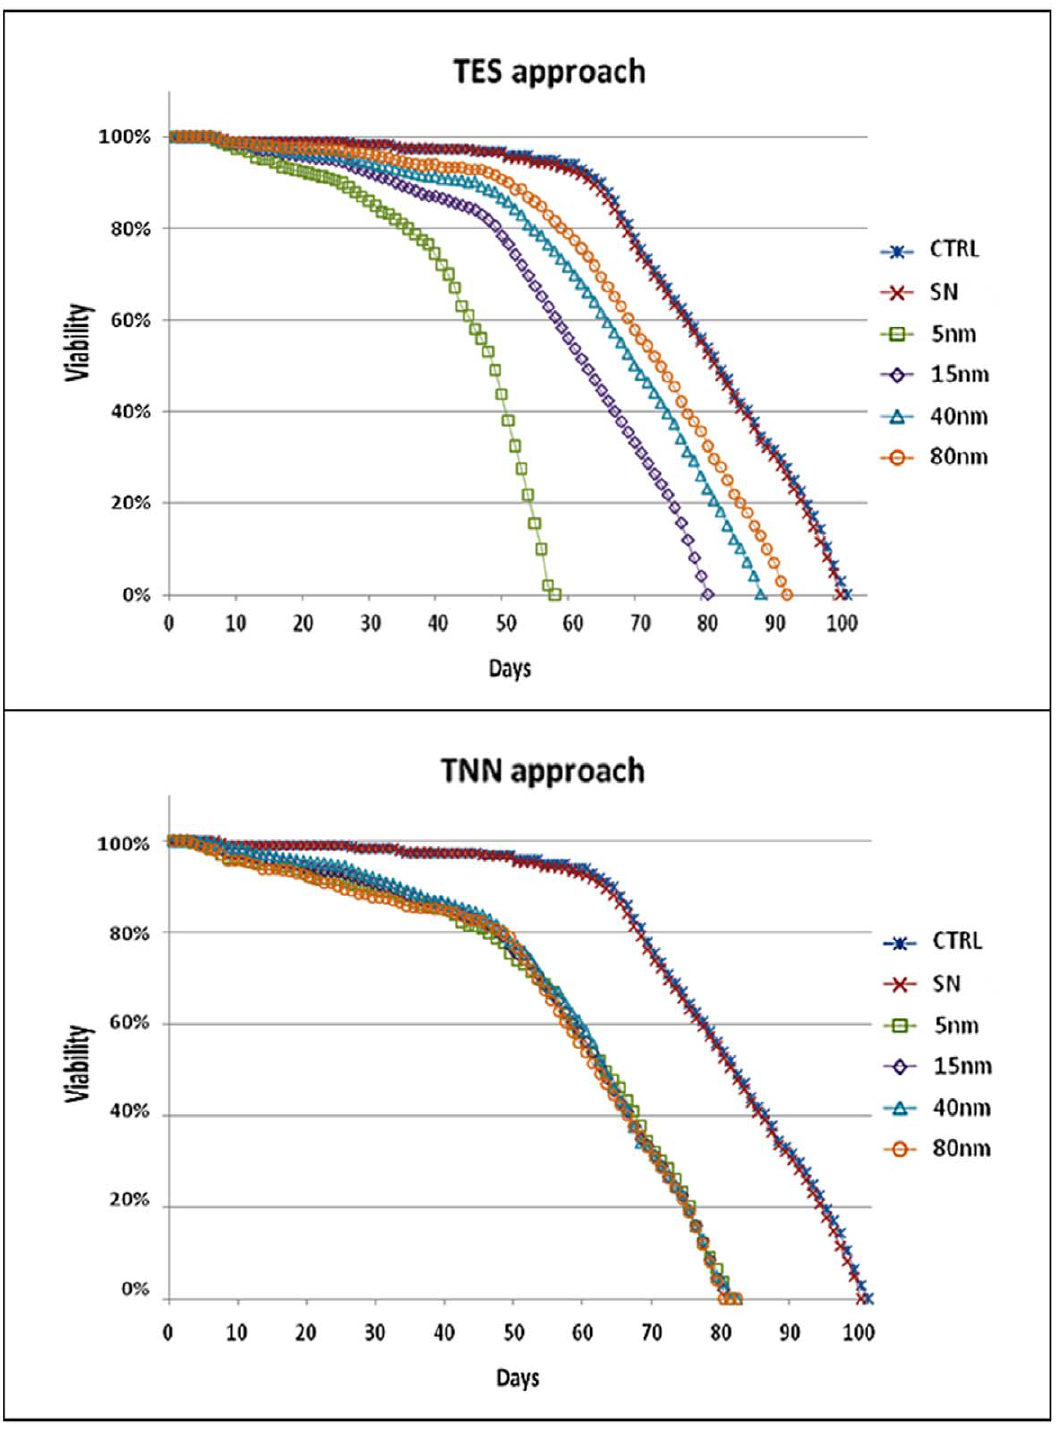
Figure 1. Lifespan curves of Drosophila flies nurtured with AuNPs treated food (5, 15, 40, and 80 nm) compared to two populations bred with normal food (CTRL) or supernatant treated food (SN). Fig. 1, top and bottom, are relative to TES and TNN approach, respectively. Experimental points represent the average from 5 independent experiments (the standard deviations are reported as the curve symbols size). The lifespan curves of both TES and TNN experiments were validated by the non-parametric log-rank (Mantel-Cox) test (see Table S3). doi:10.1371/journal.pone.0029980.g001 (900 vs. 3.5 pM for 5 and 80 nm AuNPs, respectively, see also constant (100 pM) for all the AuNPs sizes. In this test (Fig. 1, Table S1). This finding is further confirmed by the TNN bottom), in fact, the lifespan decrease was the same for all the NPs experiments, in which the concentration of the AuNPs is kept sizes ( t 50 = 62 days). This means that the Drosophil a viability is